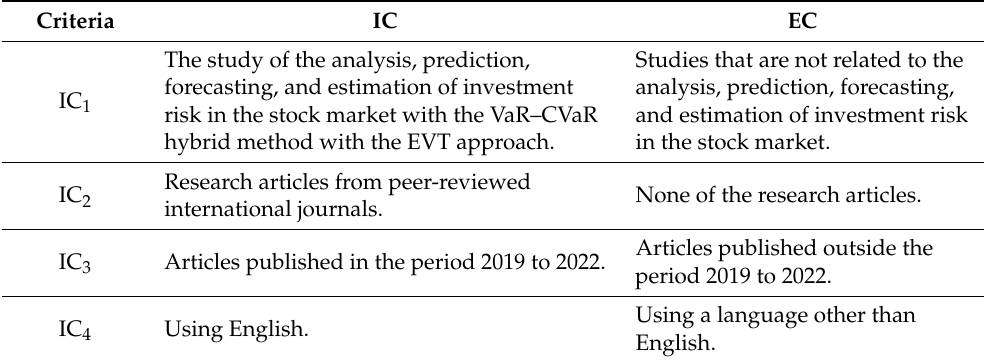
Table 2. Inclusion and exclusion